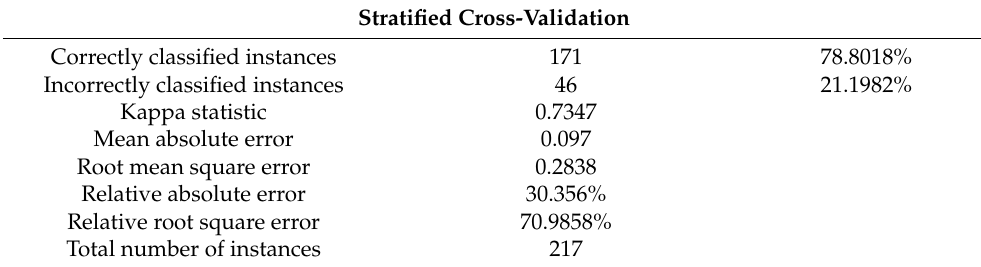
Table 16. Stratified cross-validation with a training dataset corresponding to 217 instances.